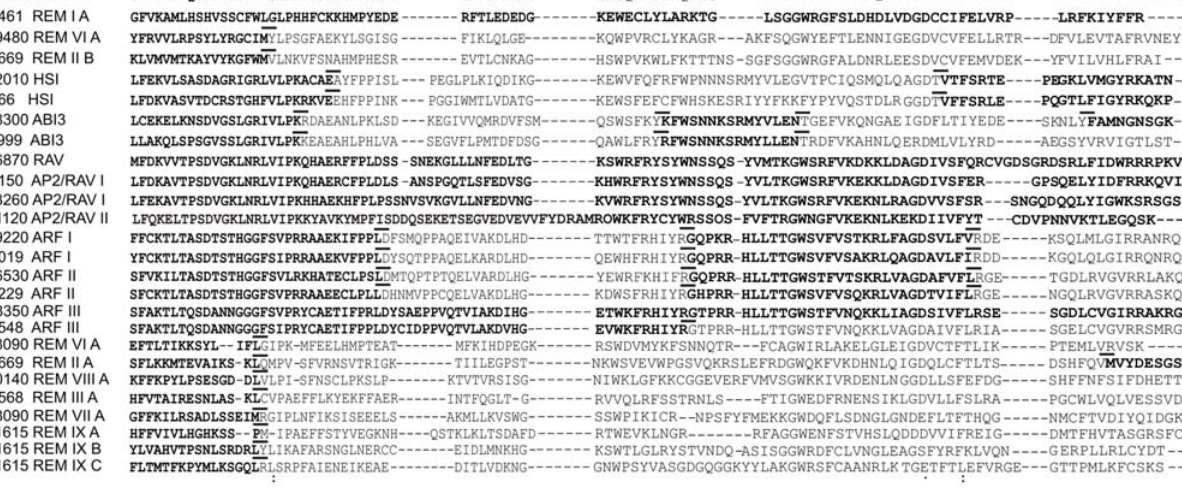
Figure 6. Alignment of amino acid sequences and exon/intron structures of B3 domain from a representative member of all A. thaliana and P.patens groups. Gaps are indicated by dashes. Underlined letters denote splicing sites. Bold and regular letter were used to help visualization of different exons.